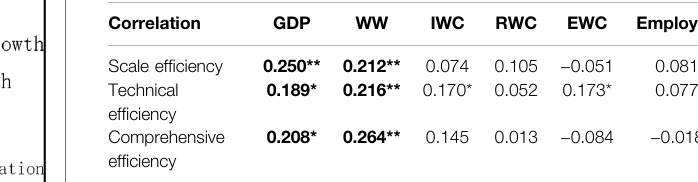
TABLE 8 | Average Malmquist index and its decomposition value of cities in Guangdong Province in 2019 –